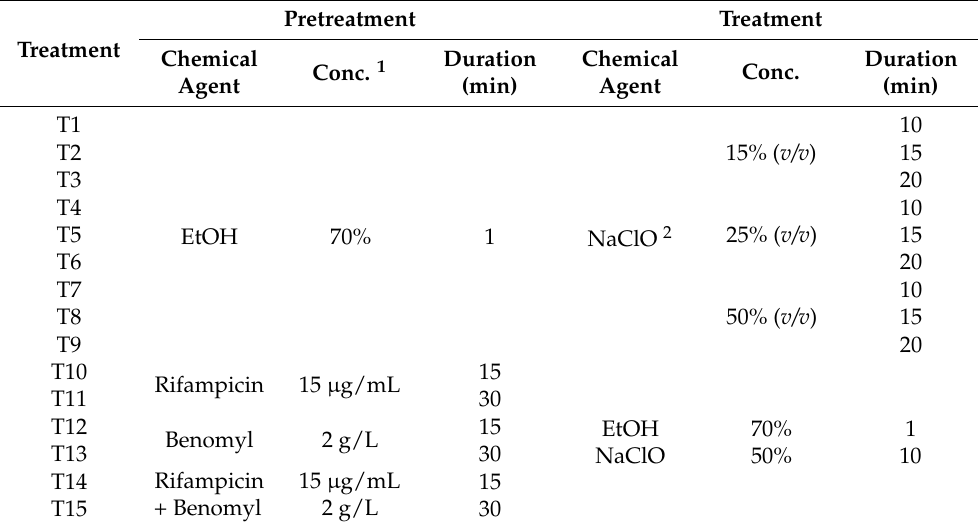
Table 2. Composition of asepsis treatments for nodal explants of P. quadrangularis